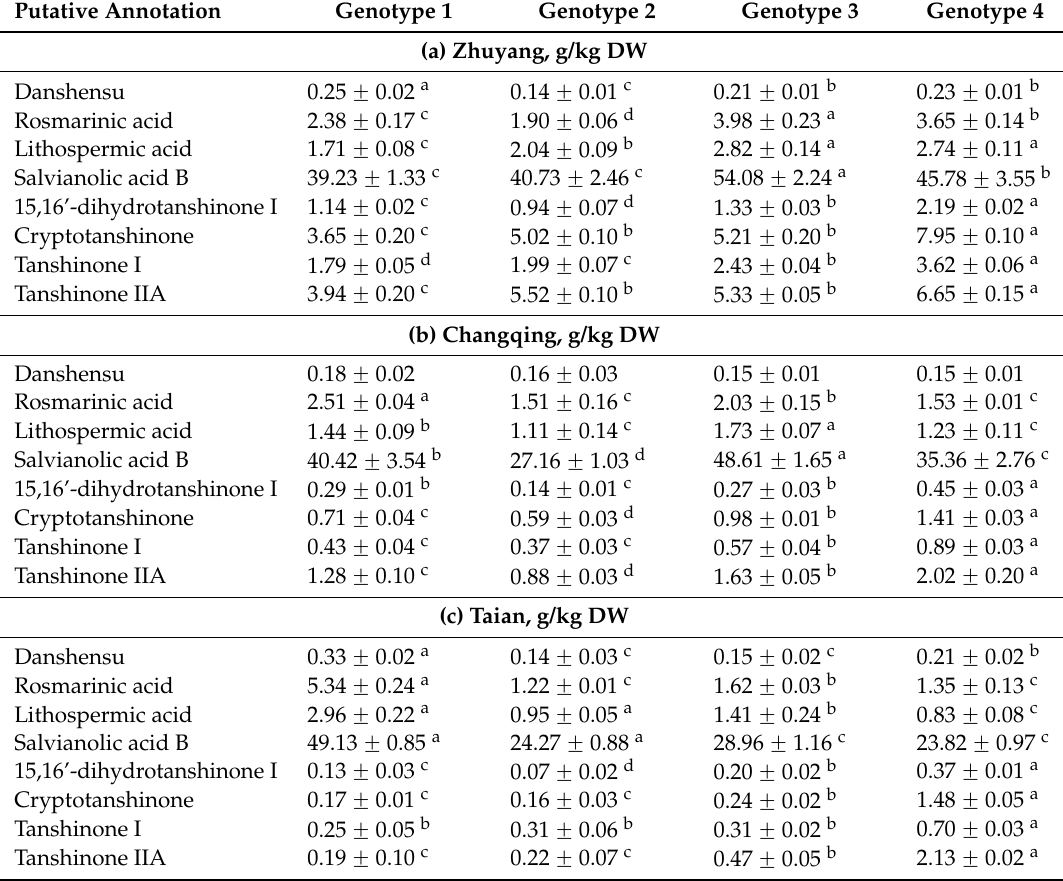
Table 2. Metabolites content of S. miltiorrhiza extracts from different genotypes for each location (Zhuyang, Changqing,